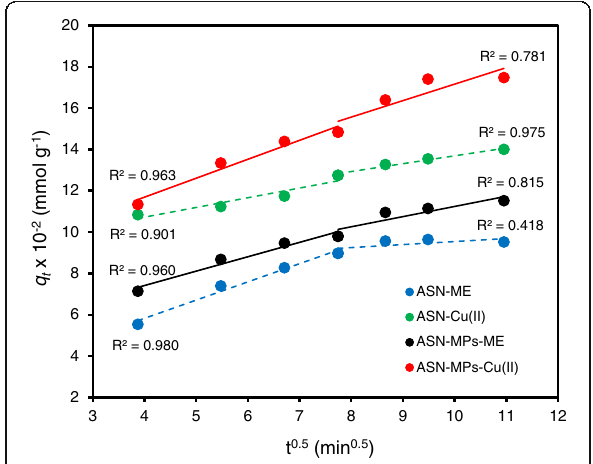
Fig. 7 Intra-particle diffusion (IPD) model-predicted kinetics of ME and Cu(II) cations sorption by ASN and